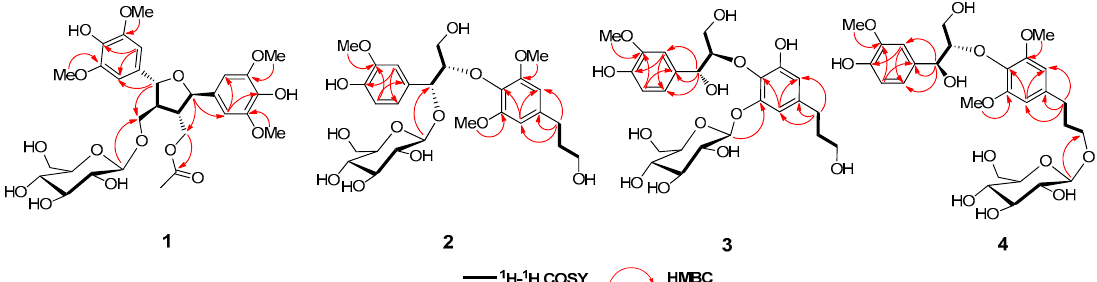
Figure 2. Key HMBC and 1 H- 1 H COSY correlations of compounds 1 – 4